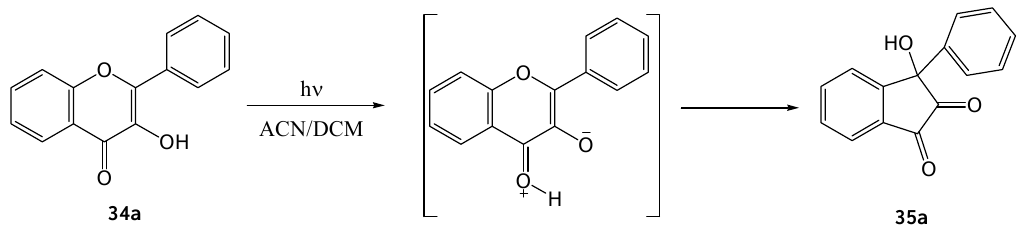
Figure 3. Proposed flavonol excited states: (GS ground state (singlet), 1 ES excited state (singlet), PT ground state of phototautomer (singlet), its singlet excited state ( 1 PT) and triplet excited state ( 3 PT) a = light absorbtion; b = intersystem crossing; c and d = photochemical reaction; e = light energy